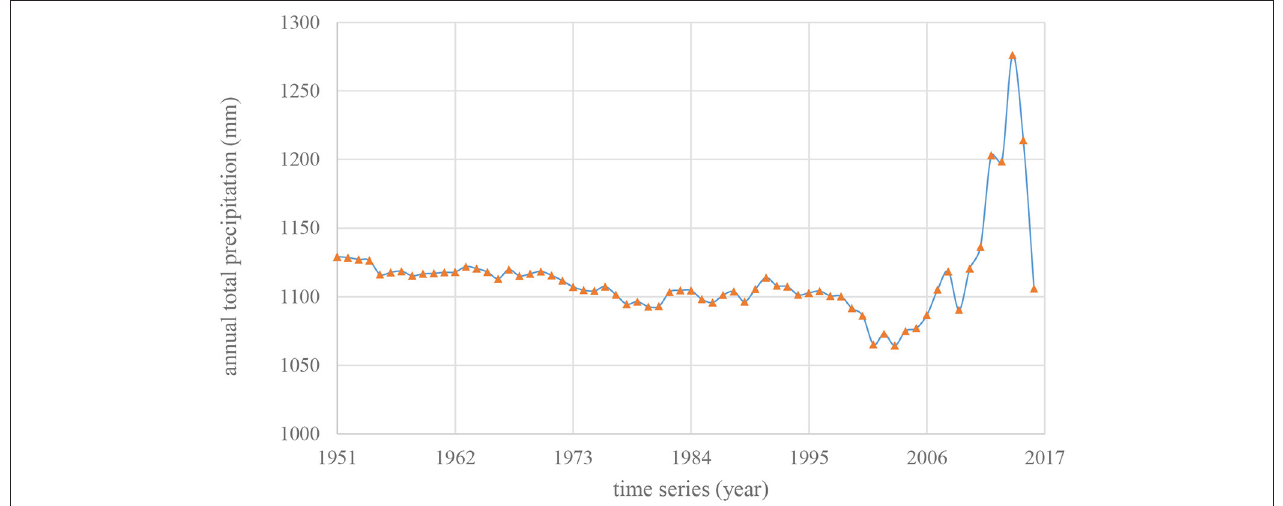
FIGURE 2 | Annual Total Precipitation (Guizhou Meteorological Bureau, 2020), adapted by the authors.